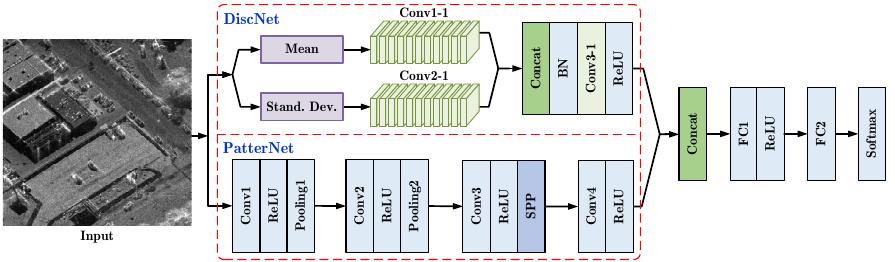
Figure 5. Architecture of the PSNet. PSNet consists of two sub-nets, including the DiscNet and the PatterNet, in which both fluctuation and pattern representations of SAR image are learned for the classification task. Max pooling is used in the